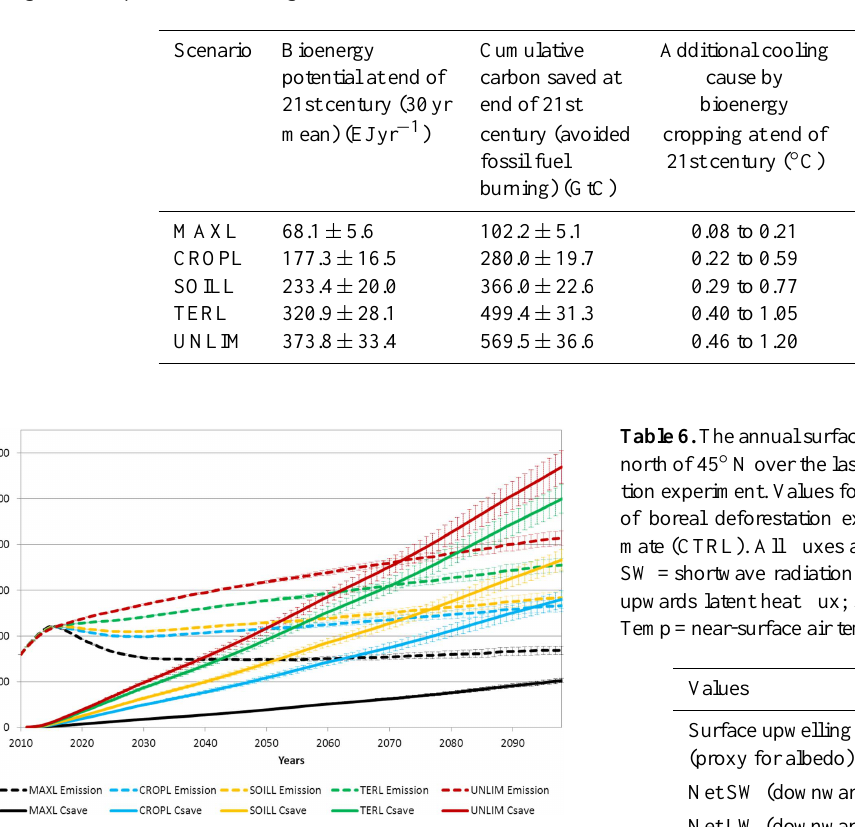
Table 5. The bioenergy potentials, the cumulative carbon saved by avoided burning of fossil fuels and the corresponding potential additional cooling of the respective land management scenarios.